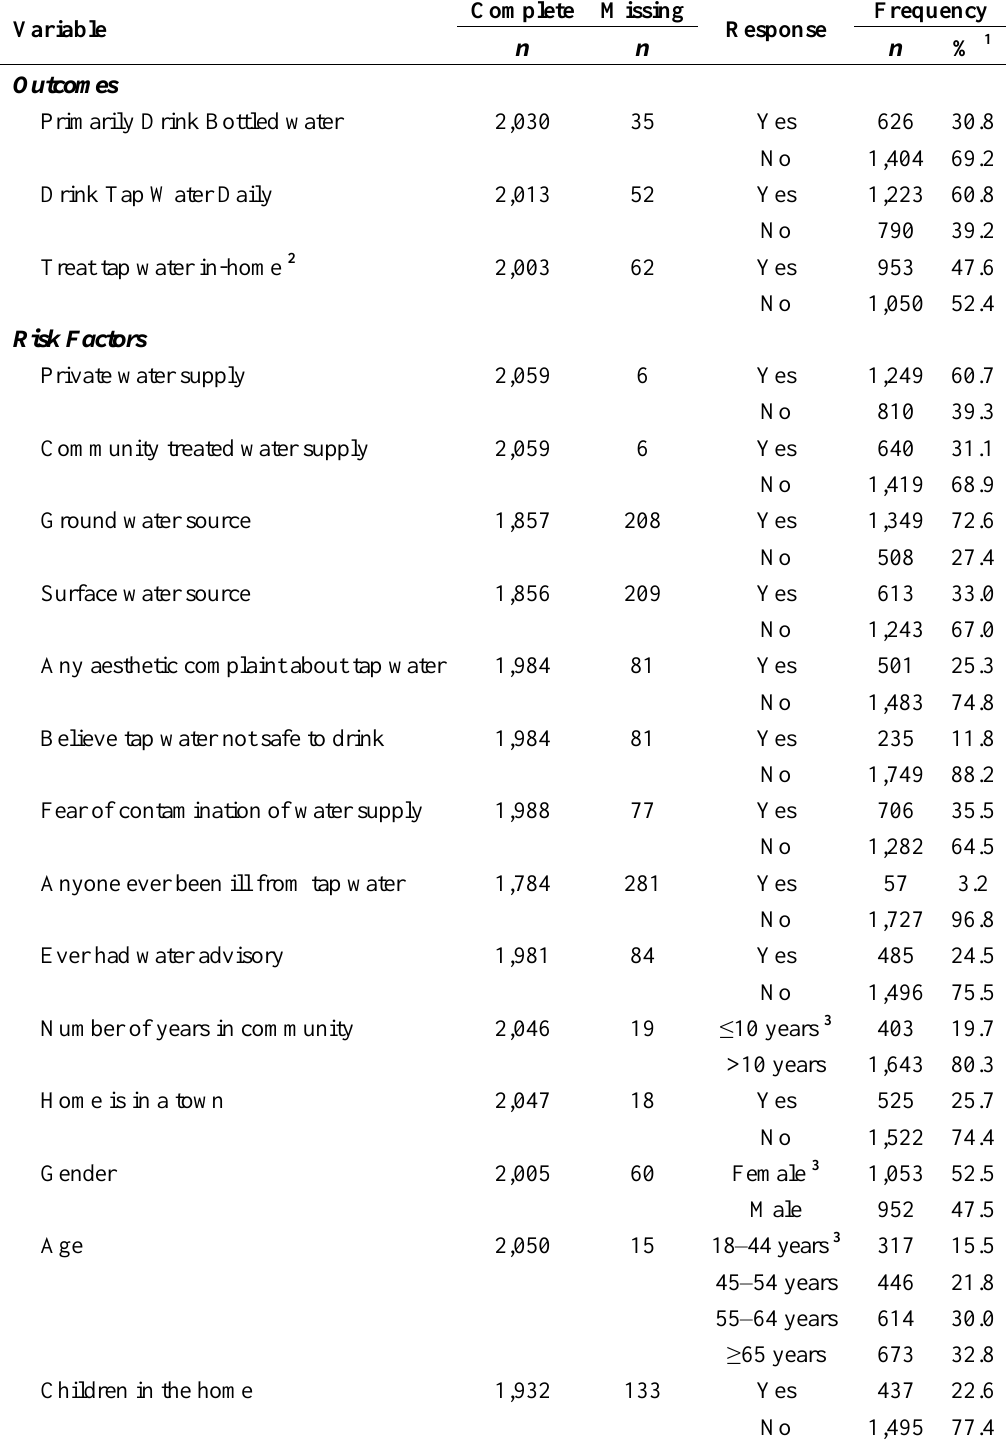
Table 1. Number of complete and missing responses and the proportion of respondents at each level for the outcomes modeled and risk factors